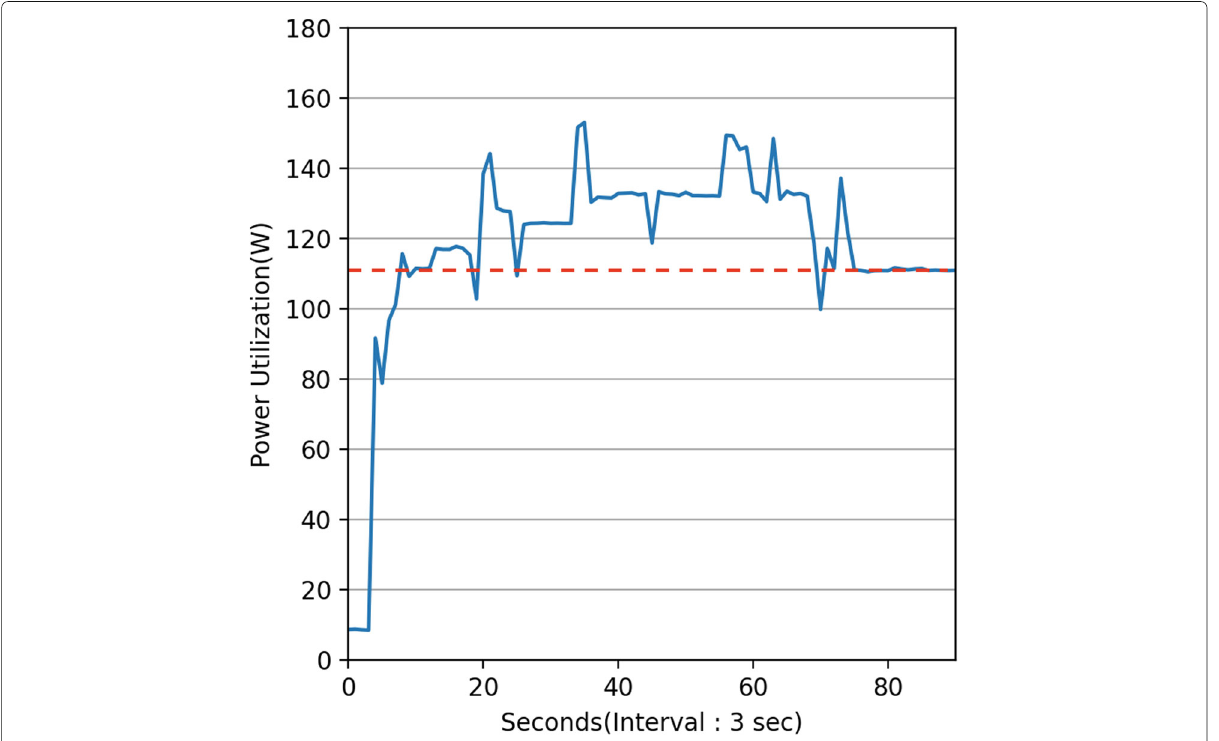
Fig. 4 Power Utilization Variation When the Host